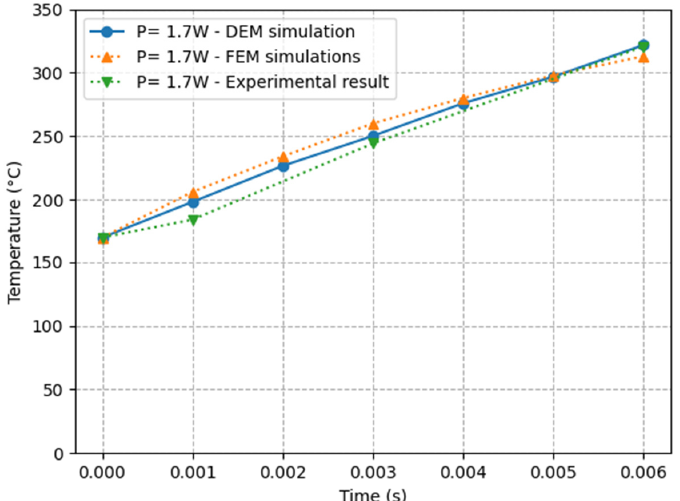
Figure 11. Comparison of the temperature evolution in the center of the laser beam with the works of [8,9] using the same parameters mentioned in Table 1.